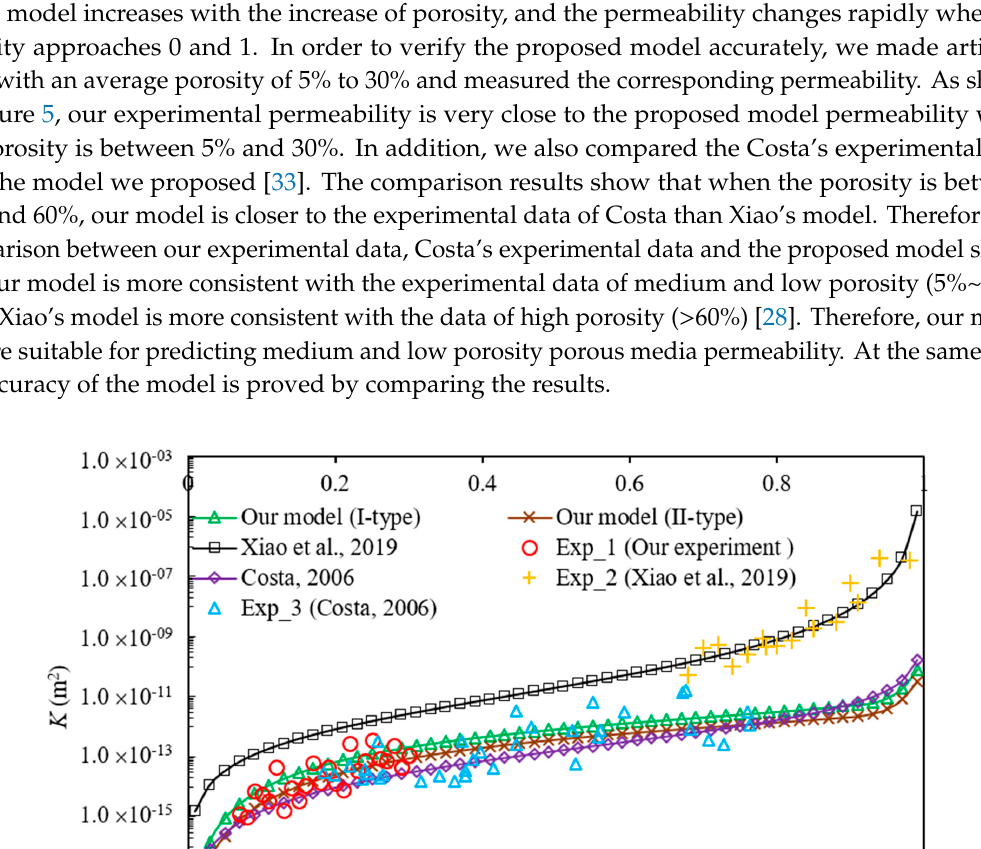
Figure 6. The relationship between pore diameter and porosity of capillary bundle model section. By substituting Equations (4), (8), (24), and (25) into Equations (22) and (23), it can be known that the tortuosity fractal dimension and the pore area fractal dimension are all functions of porosity. Figure 7 shows the effect of porosity on fractal dimension. With the increase of porosity, the tortuosity